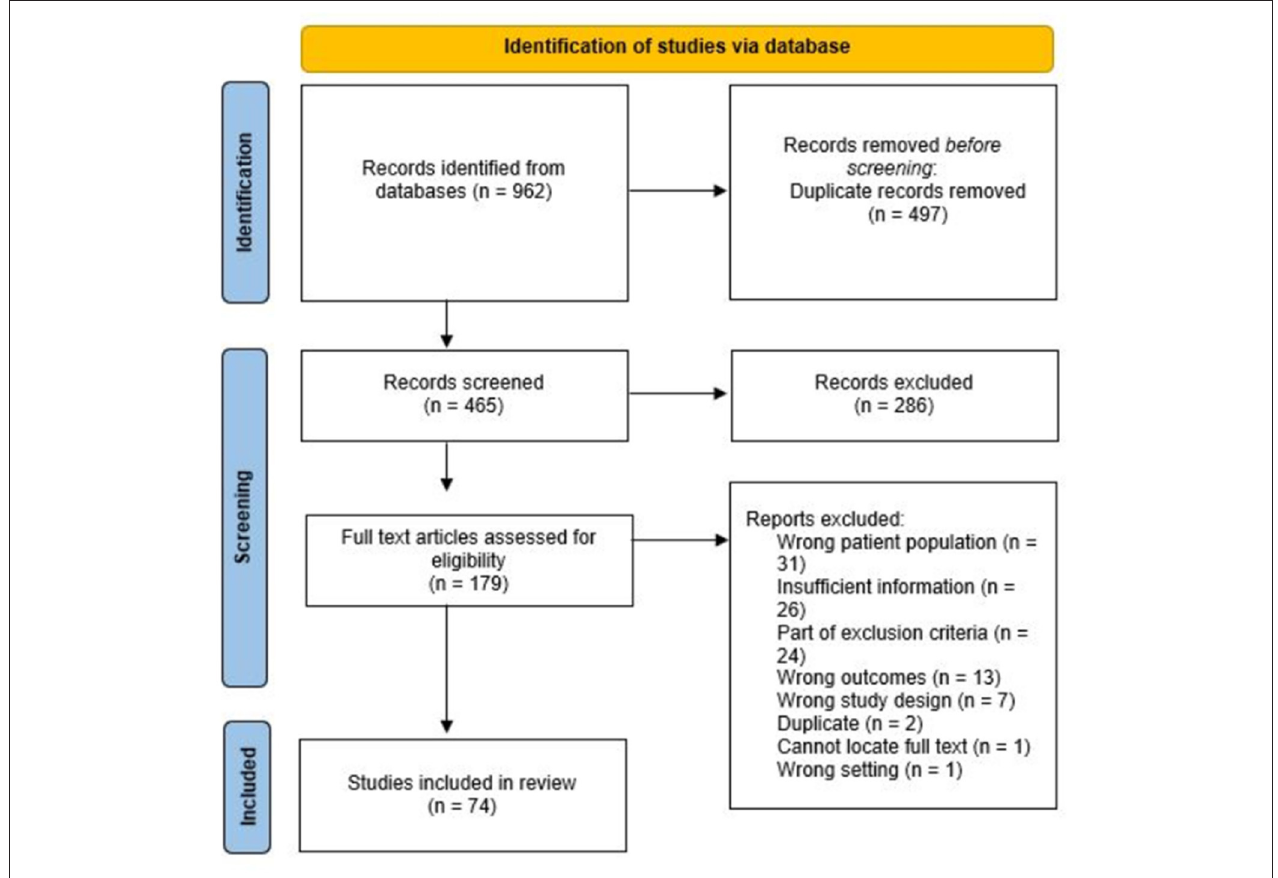
FIGURE 2 | Scoping review